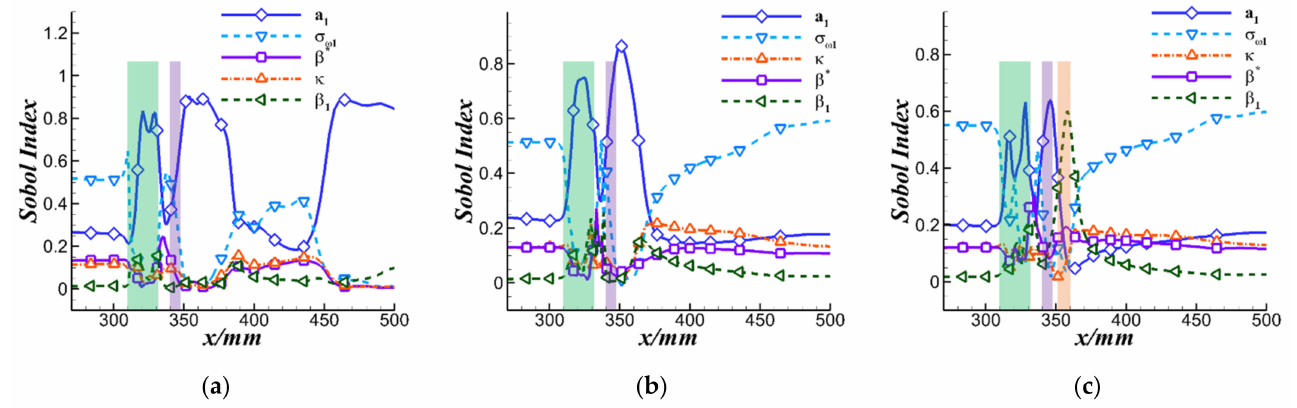
Figure 12. Distributions of the Sobol indices of model’s parameters for the wall properties in θ = 14 ◦ case. ( a ) Wall pressure; ( b ) skin friction; ( c ) wall heat